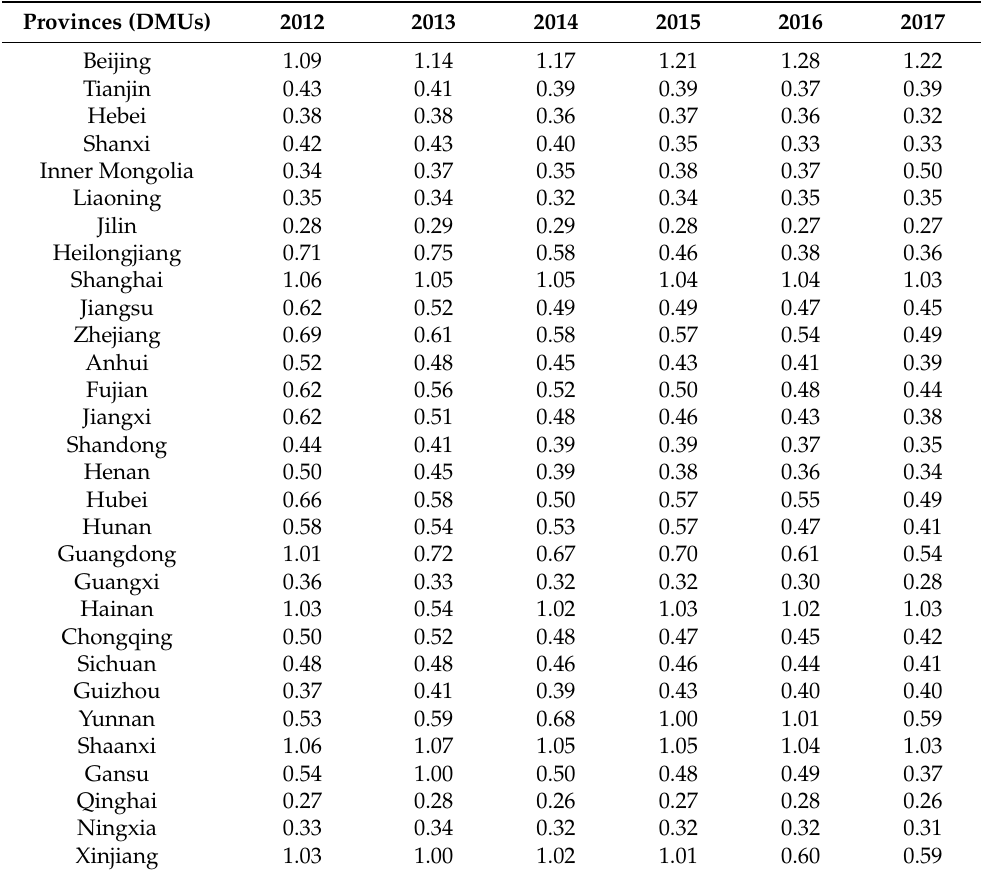
Table 1. The energy and environmental efficiency (EEE) of the industrial sector in various provinces from 2012 to